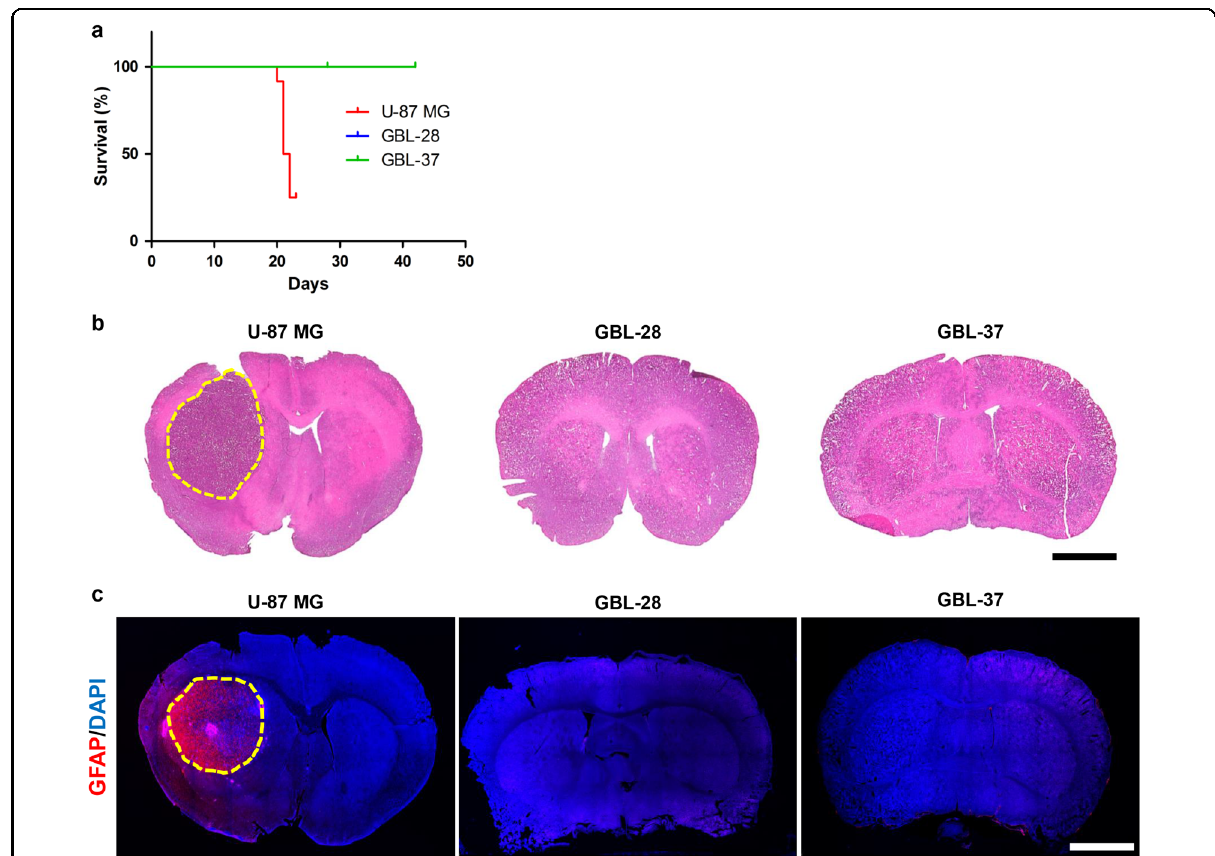
Fig. 2 Unreliability of the orthotopic transplantation of patient-derived glioblastoma cells. a Kaplan – Meier survival curves of mice ( n = 12) intracranially injected with U-87 MG, GBL-28, or GBL-37 cells. The curve for the GBL-28 group was moved upward by 2% to prevent overlap. b Representative images of H&E-stained sections of the brain tissue of mice at 4 – 6 weeks after the intracranial injection of U-87 MG (4 weeks), GBL-28 (6 weeks), or GBL-37 (6 weeks) cells. The yellow dashed lines indicate the intracranial tumors. Scale bar: 2 mm. c Representative images of brain sections stained using DAPI and an antibody speci fi c for GFAP at 4 – 6 weeks after the intracranial injection of U-87 MG (4 weeks), GBL-28 (6 weeks), or GBL-37 (6 weeks) cells. The yellow dashed lines indicate the intracranial tumors. Scale bar: 2